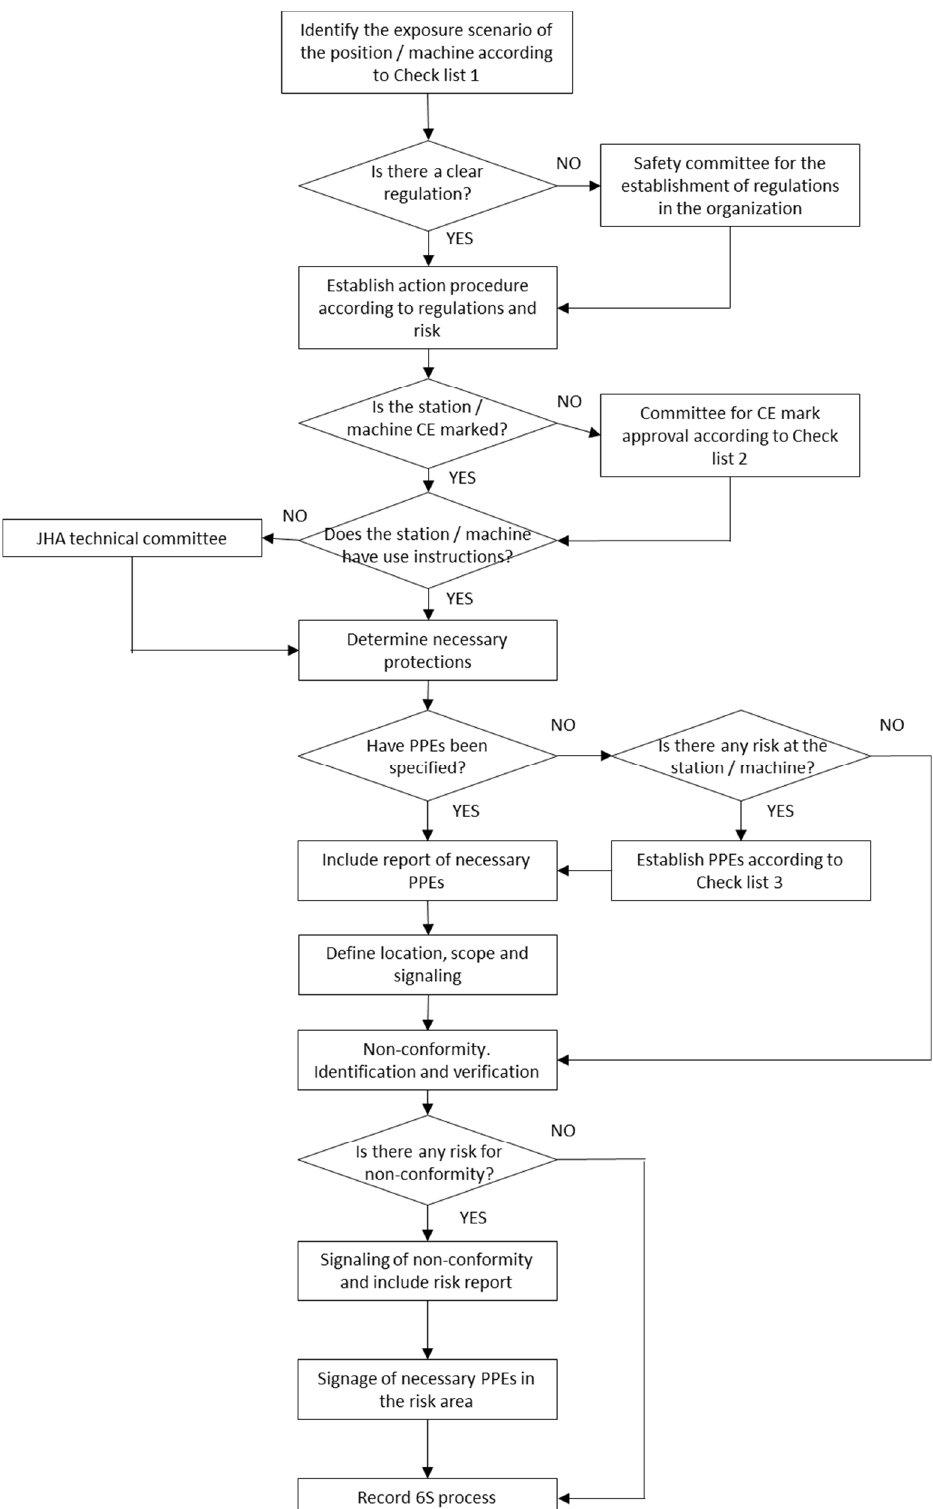
Figure 3. Safety implementation flow chart.